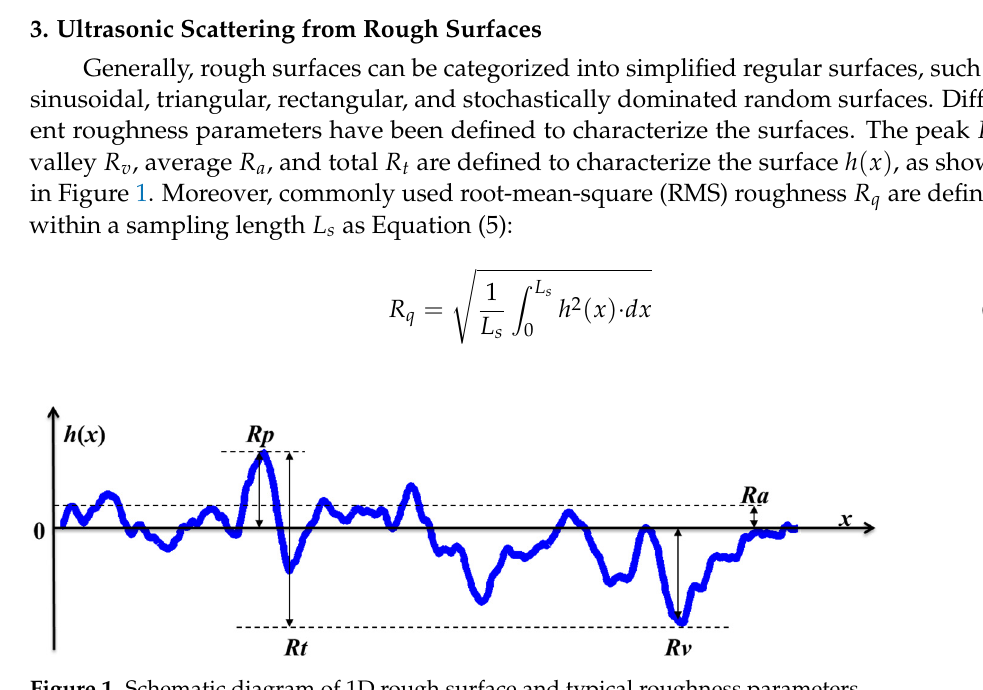
Figure 1. Schematic diagram of 1D rough surface and typical roughness